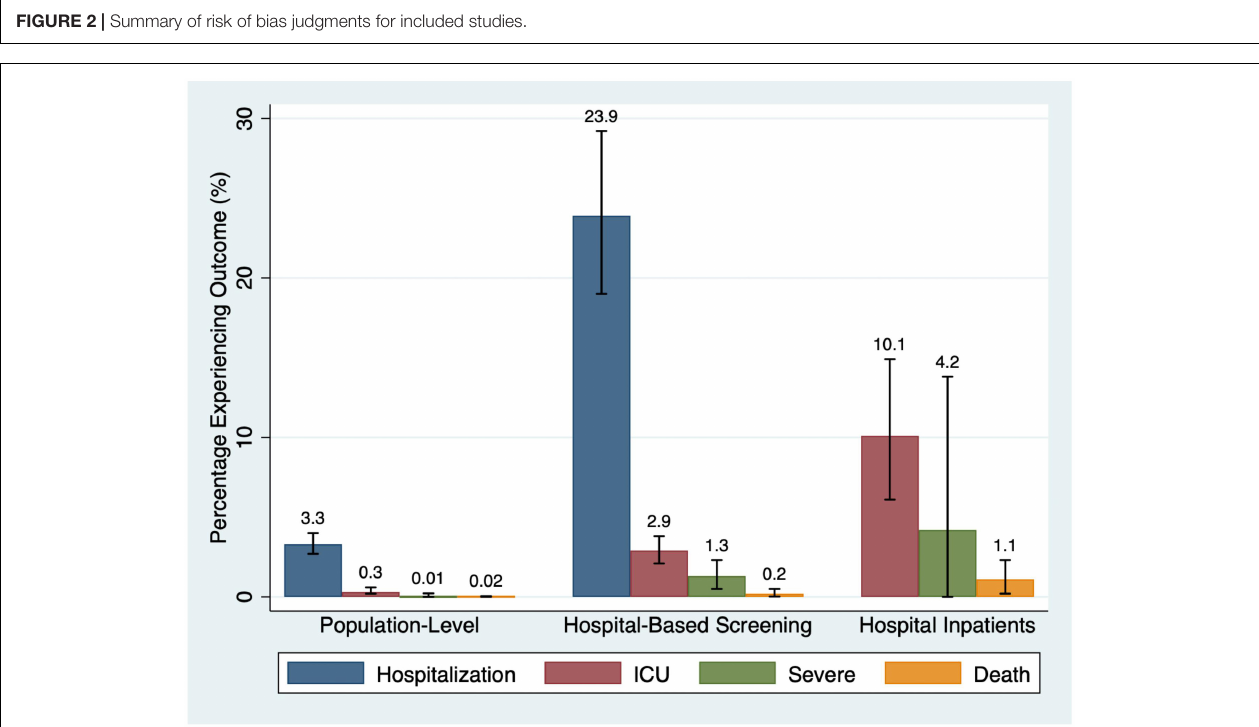
FIGURE 3 | Percentage of participants experiencing outcomes by study